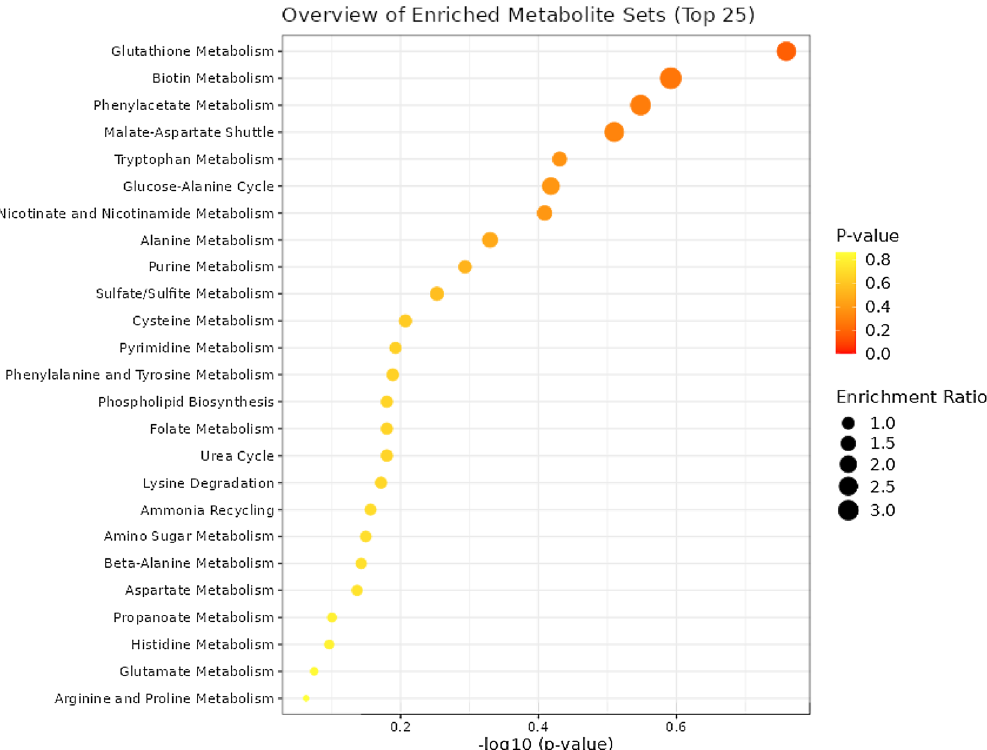
Figure 5. Metabolite Set Enrichment Analysis of top 37 differential metabolites derived from medwakh smokers in comparison to non-smoking controls. Top enriched pathways included glutathione metabolism,